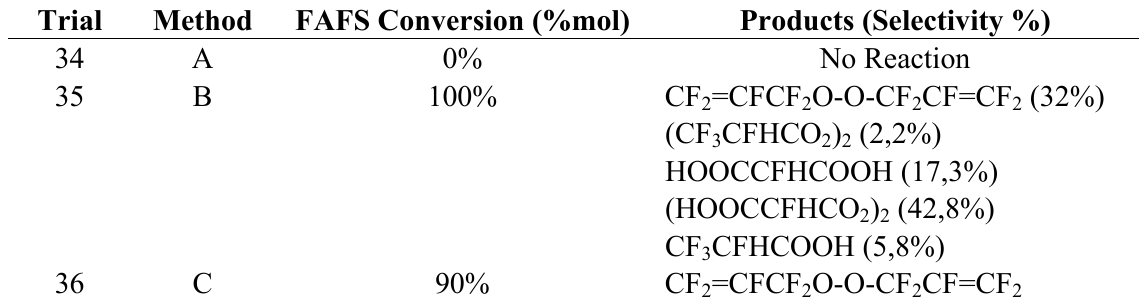
O to FAFS—Product distributions and 2 2